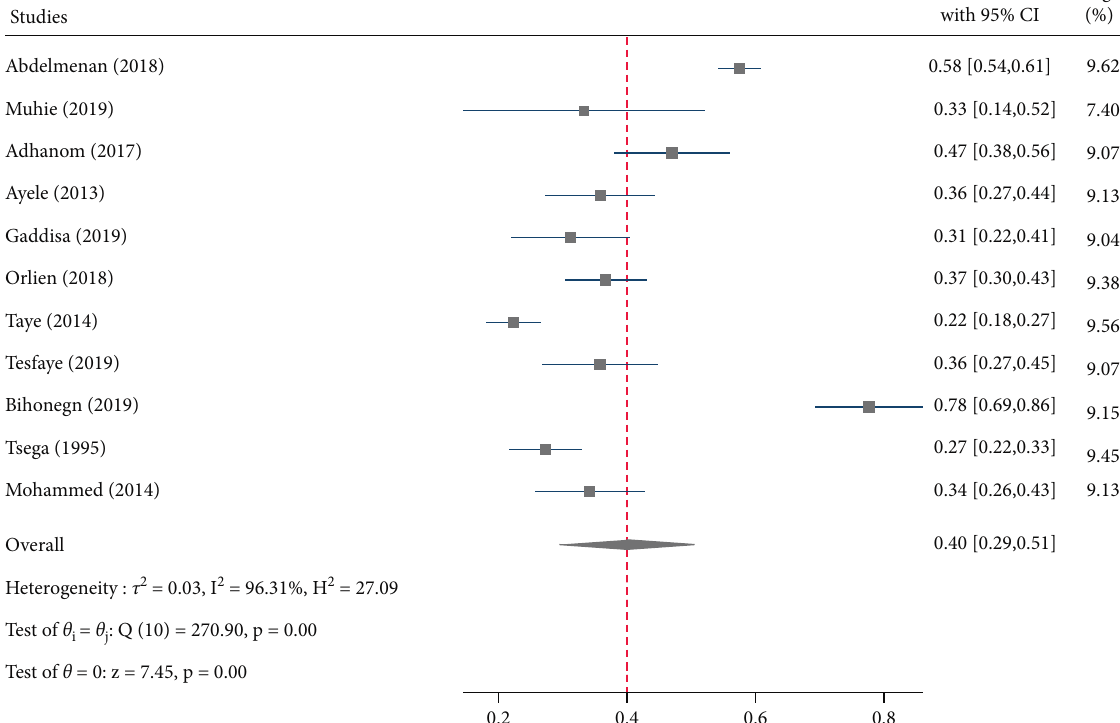
Heterogeneity : τ 2 = 0.03, I 2 = 96.31%, H 2 = 27.09 Test of θ i = θ j : Q (10) = 270.90, p = 0.00 Test of θ = 0: z = 7.45, p = 0.00